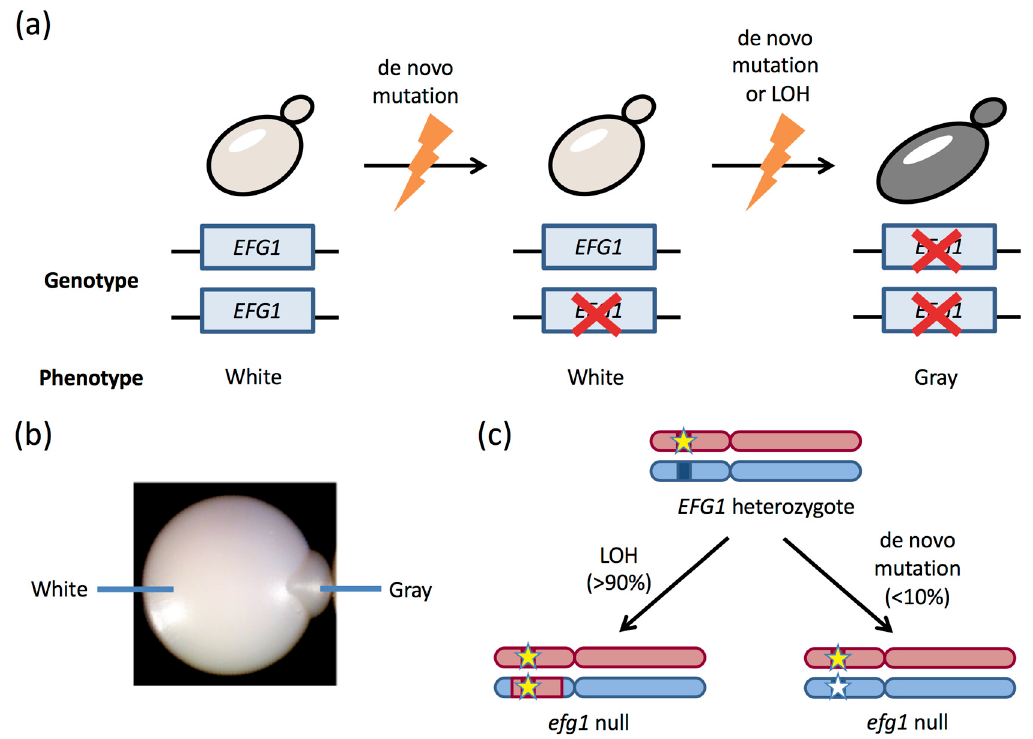
Figure 3. Genetic events at the EFG1 locus can impact C. albicans phenotypes. ( a ) Most C. albicans isolates are diploid and carry two functional alleles of EFG1. However, one EFG1 allele can be disrupted by a de novo mutation, and the second allele can then be lost either by LOH or by a second de novo mutational event. Cells with functional EFG1 are in the ‘white’ state, whereas the complete loss of EFG1 function causes cells to adopt the ‘gray’ state. ( b ) Image of a single colony showing white efg1 / EFG1 cells that have given rise to a sector of gray efg1 null cells. ( c ) Clinical isolates that are heterozygous for EFG1 can lose the functional EFG1 allele either by LOH ( > 90% of events) or de novo mutation ( < 10% of events). Asterisks indicate nonfunctional alleles.